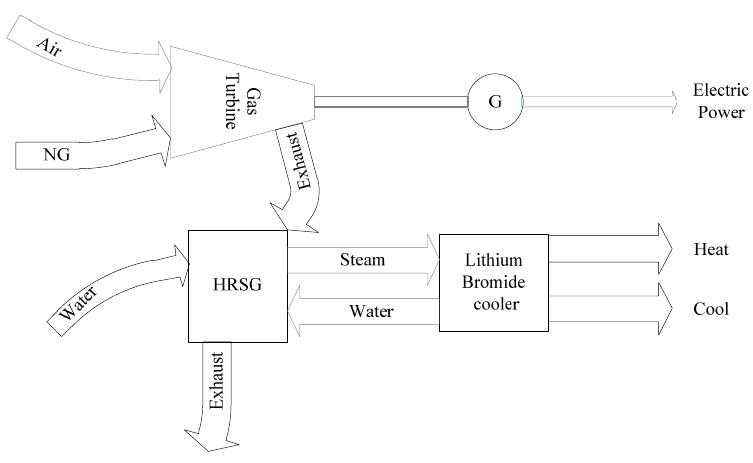
Figure 1. Flowing path working fluids in a CCHP energy system.